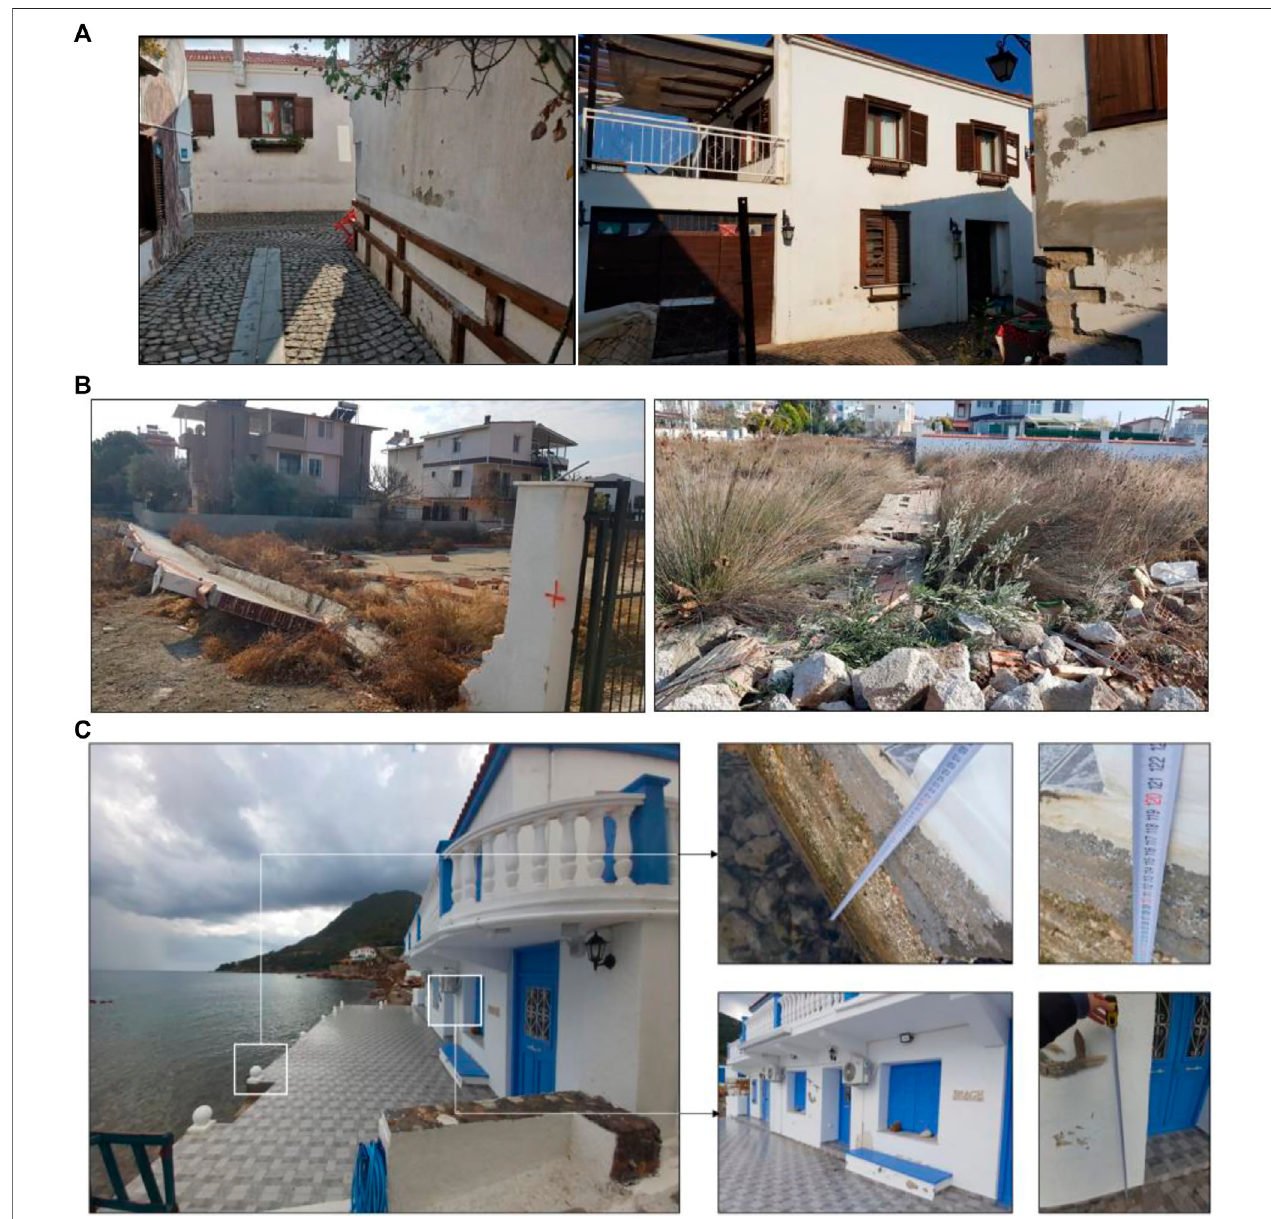
FIGURE17|(A) WatermarksonbuildingsinS ığ ac ı k,Seferihisar, (B) perimeterwalloverturningduetotsunamihydrodynamiceffectsinS ığ ac ı k (C) watermarkson building at Agios Nikolaos beach in Samos.